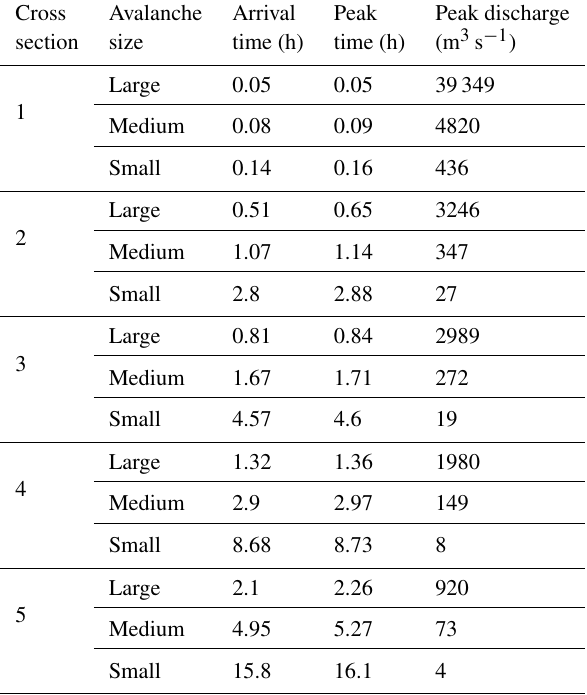
Table 6. FLO2D simulation results at cross sections downstream of Lake Palcacocha for the current lake level and a large